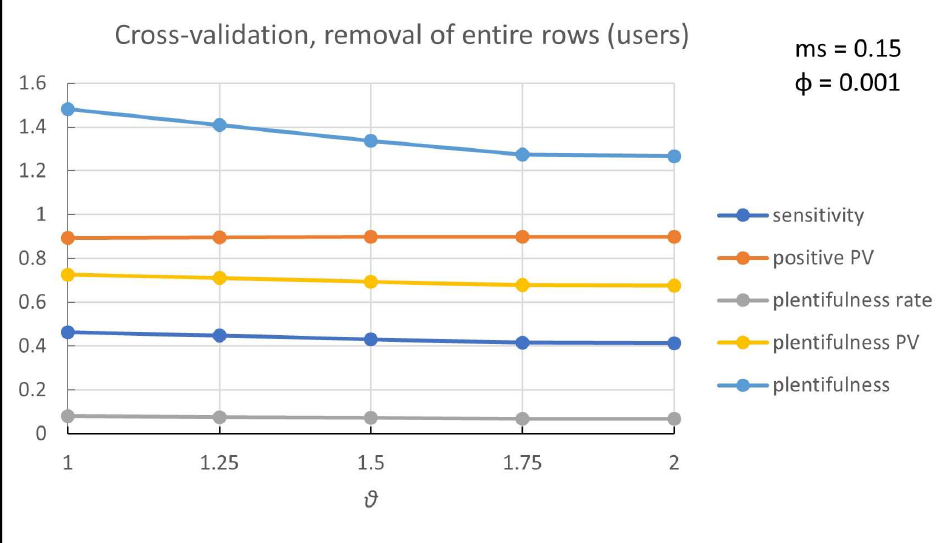
Figure 2. Cross-validation results (100% removal, minimum support = 0.15).